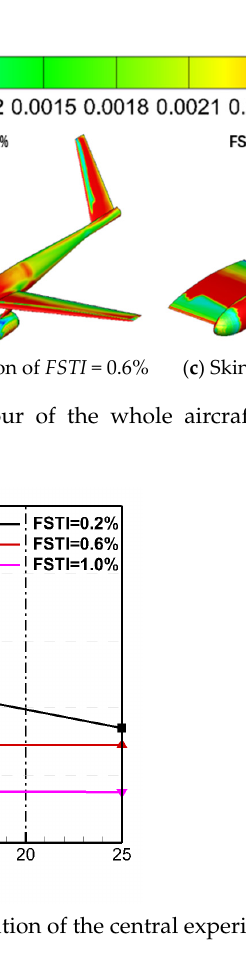
Figure 9. Comparison of C p curves of the central experiment wing with different free stream turbu- lence intensity at various locations along the span.